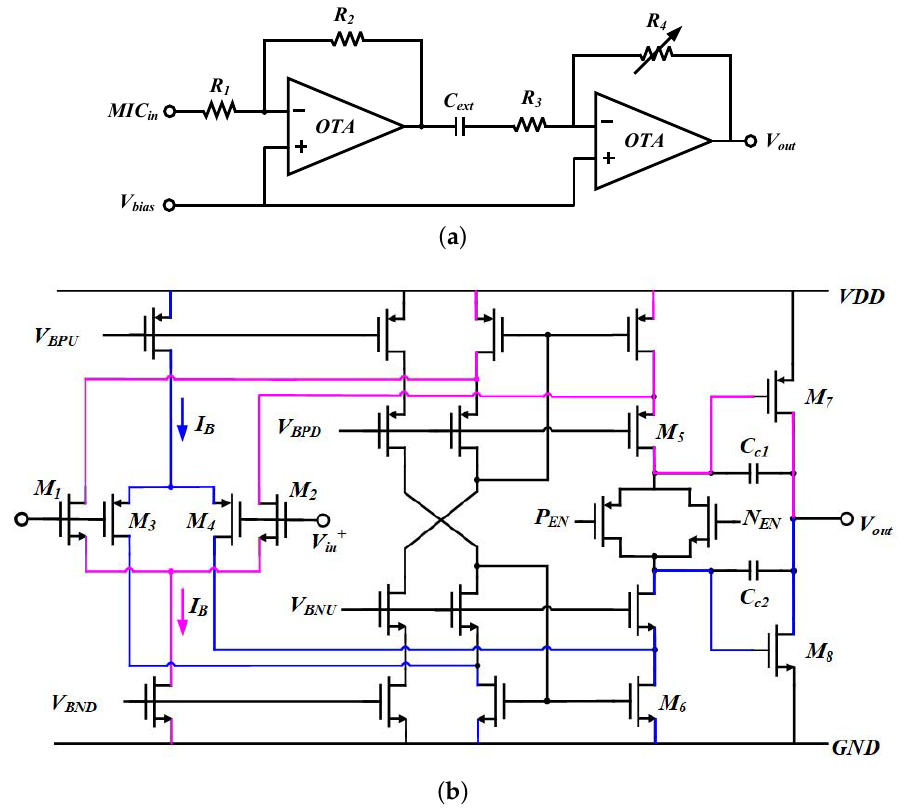
Figure 3. Schematics of ( a ) the two-stage microphone amplifier; and ( b ) each two-stage operational amplifier